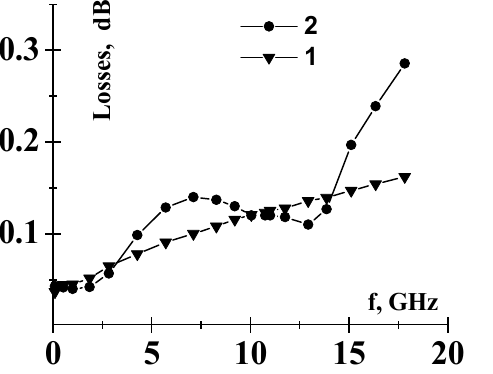
Figure 8. Frequency dependence of losses. 1-theoretical curve, 2-experimental curve.